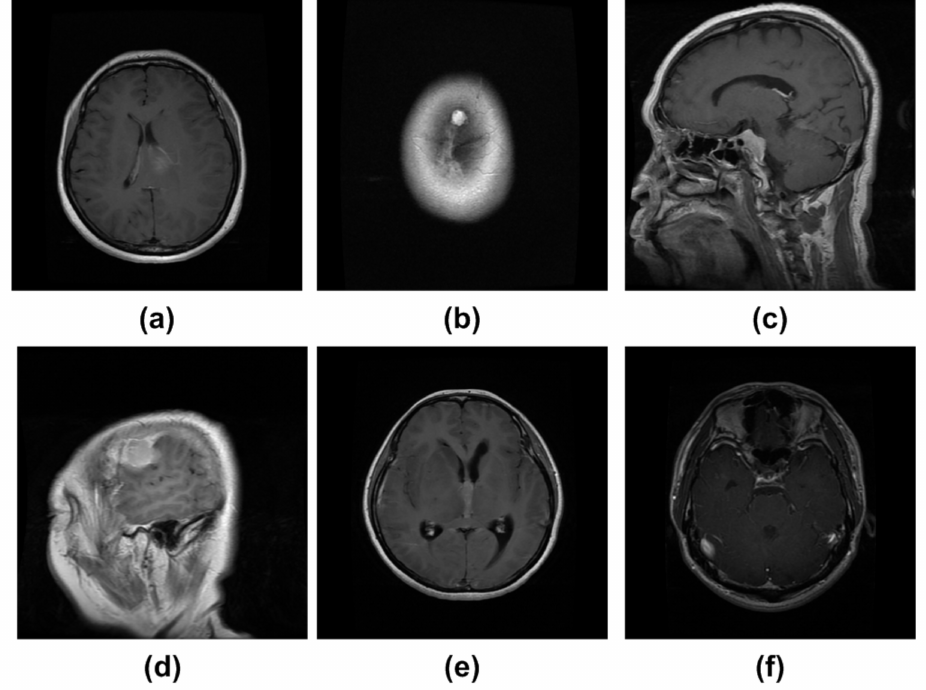
Figure 4. Sample dataset images. ( a ) Texture similarity; ( b ) noisy sample; ( c ) size variation; ( d ) blurry and brightness effect; ( e ) texture similarity; ( f ) low-contrast